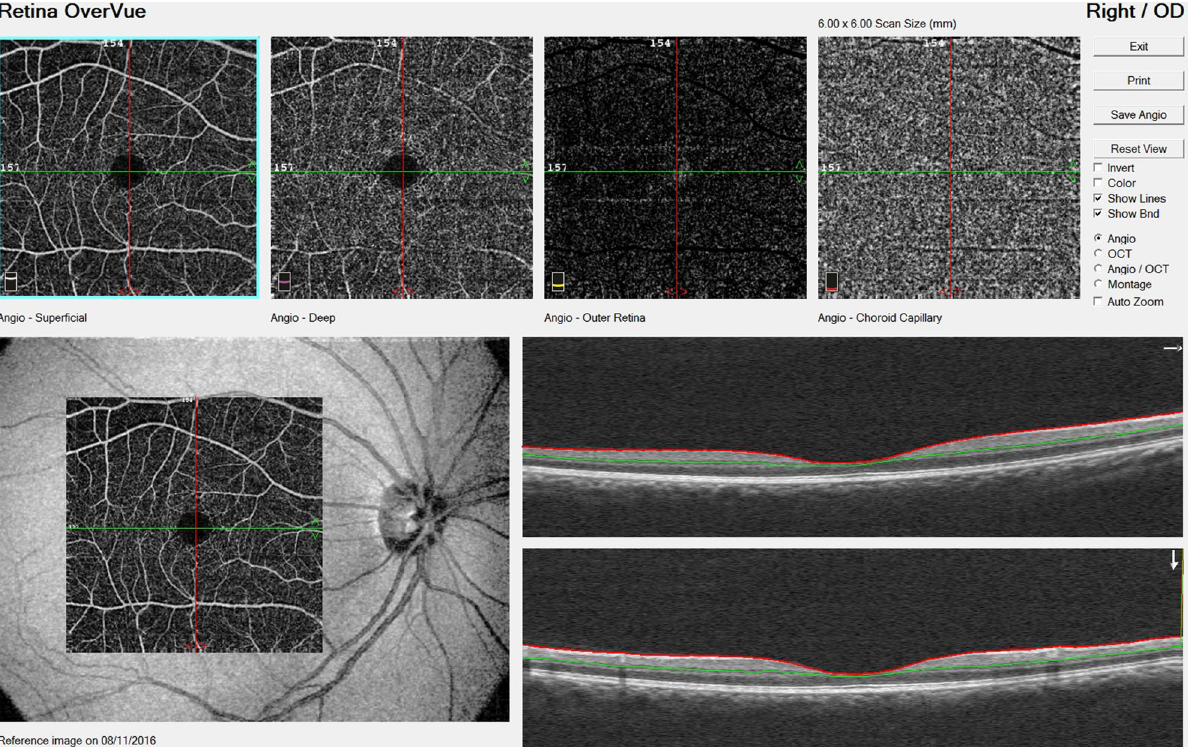
Figure 1. OCT angiogram from a single eye, showing the four retinal depths (top): the superficial retinal plexus, the deep retinal plexus, the outer retina and the choriocapillaris. Bottom left shows the scan region (darker) overlaid on the broader retina. Bottom right shows the cross-section of the superior vascular plexus